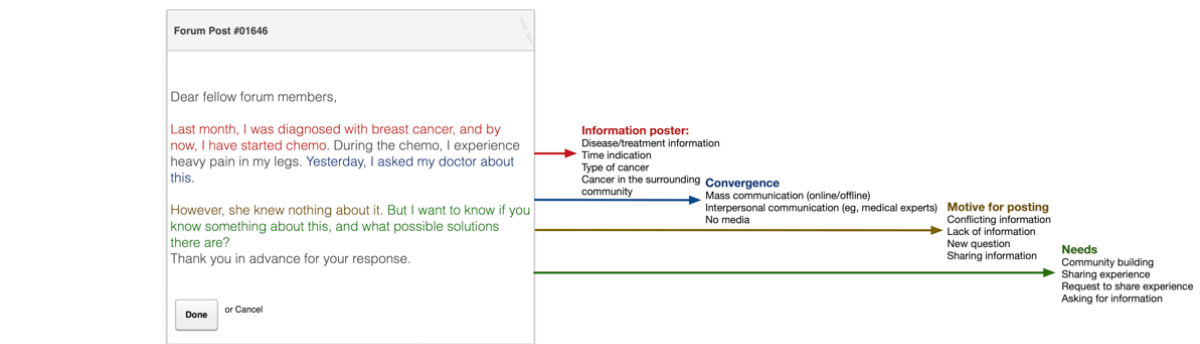
Figure 1. Example of extraction of concepts from forum